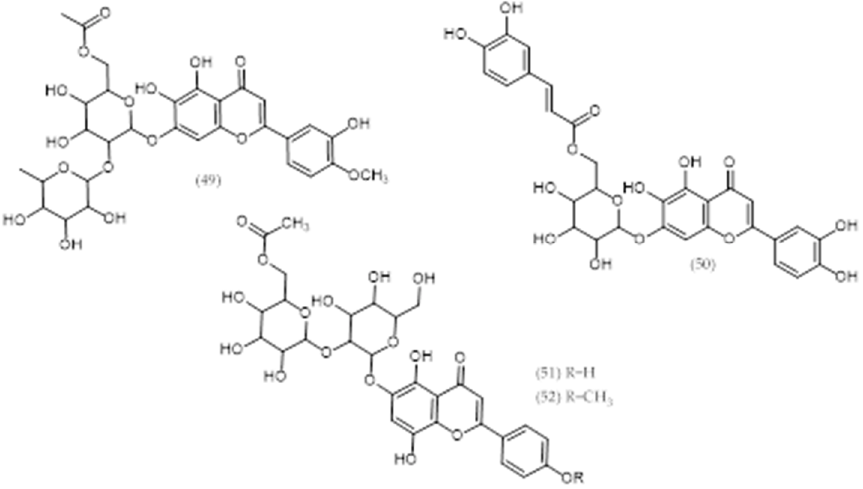
Figure 9. Phytoconstituents from Veronica longifolia , Veronica liwanensis , and Veronica orientalis .